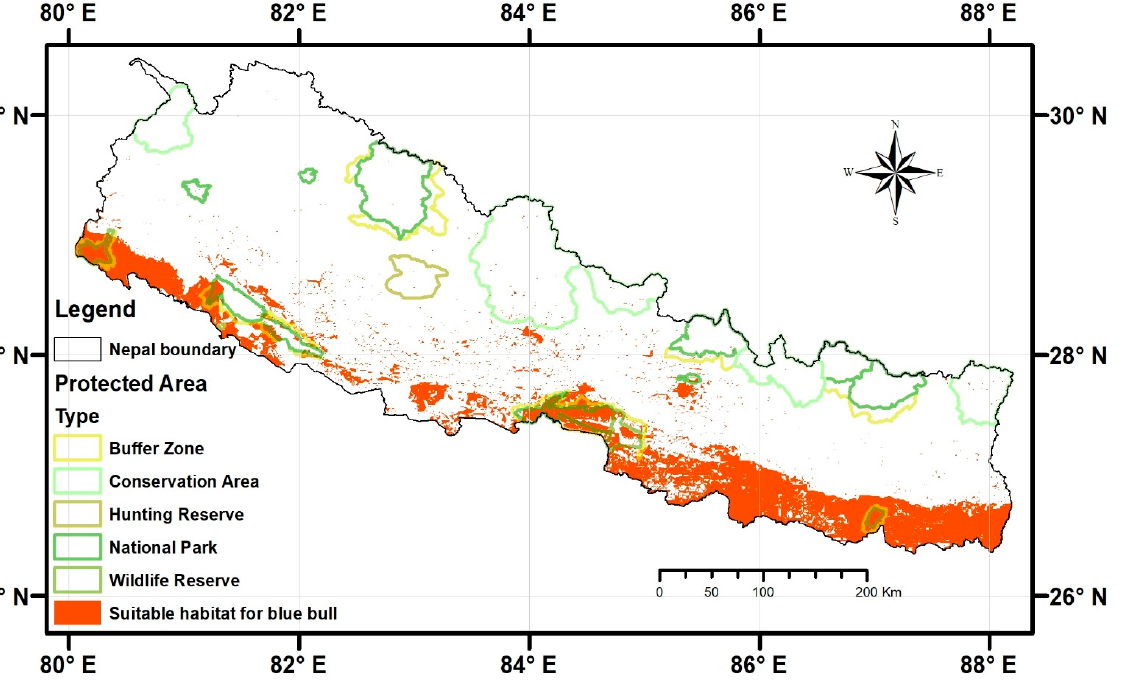
Figure 2. Predicted suitable habitats (orange color) for the Blue bull in Nepal. The protected areas of different categories across Nepal are also shown.